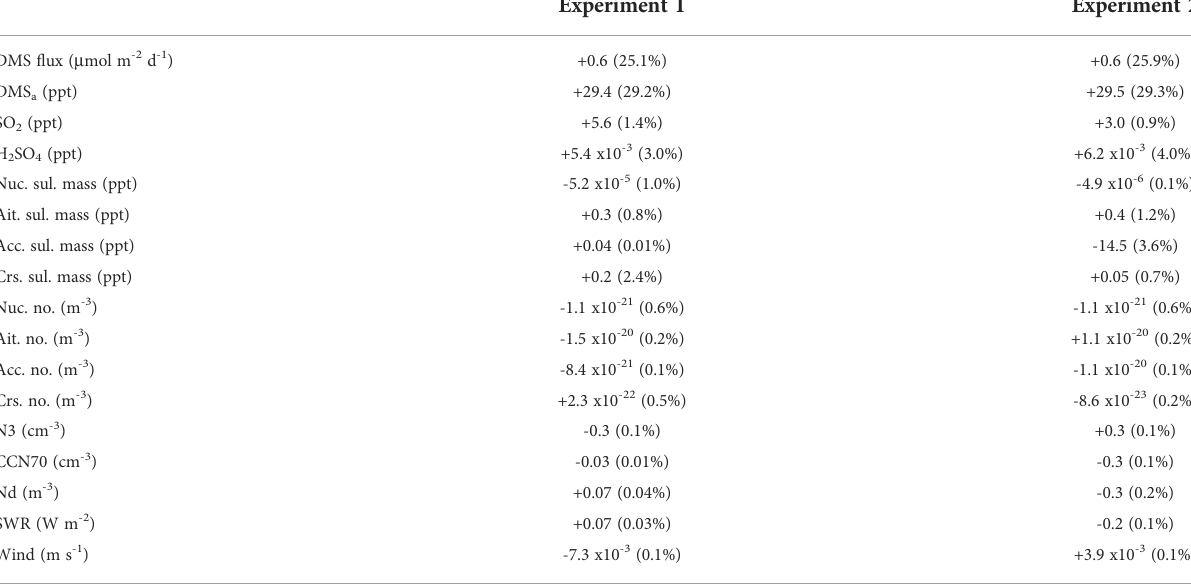
TABLE 2 Annual mean change [actual (percentage)] between the GBR DMS and L11 simulations area-averaged over north-eastern